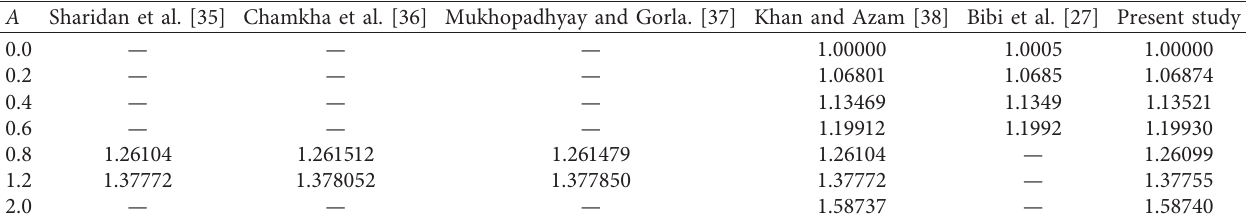
Table 3: Comparisons of results on − f ″ ( 0 ) for We � M � K A . A Sharidan et al. [35] Chamkha et al. [36] Mukhopadhyay and Gorla. [37] Khan and Azam [38] Bibi et al. [27] Present